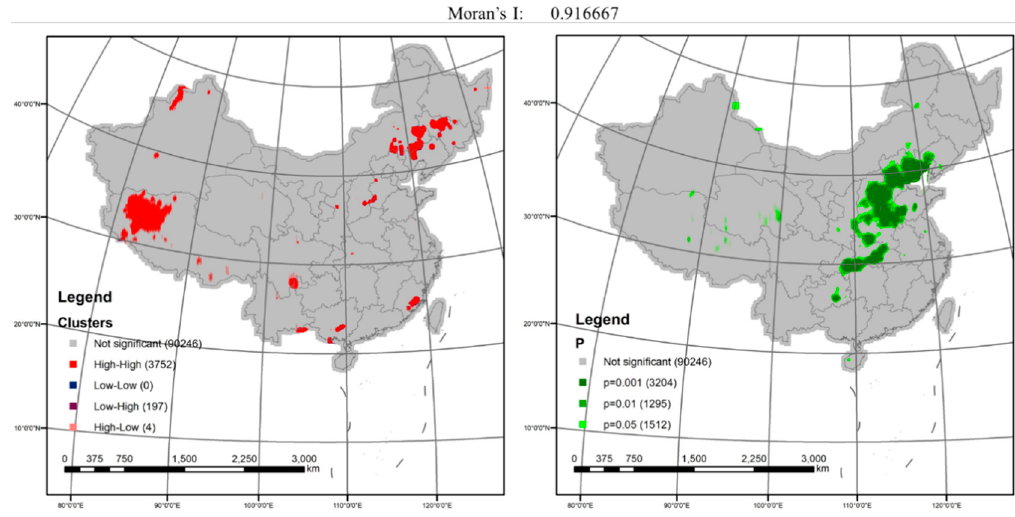
Figure 7. Moran’s I scatter plot ( left ) and p–values ( right ) in China on 28 July 2016.